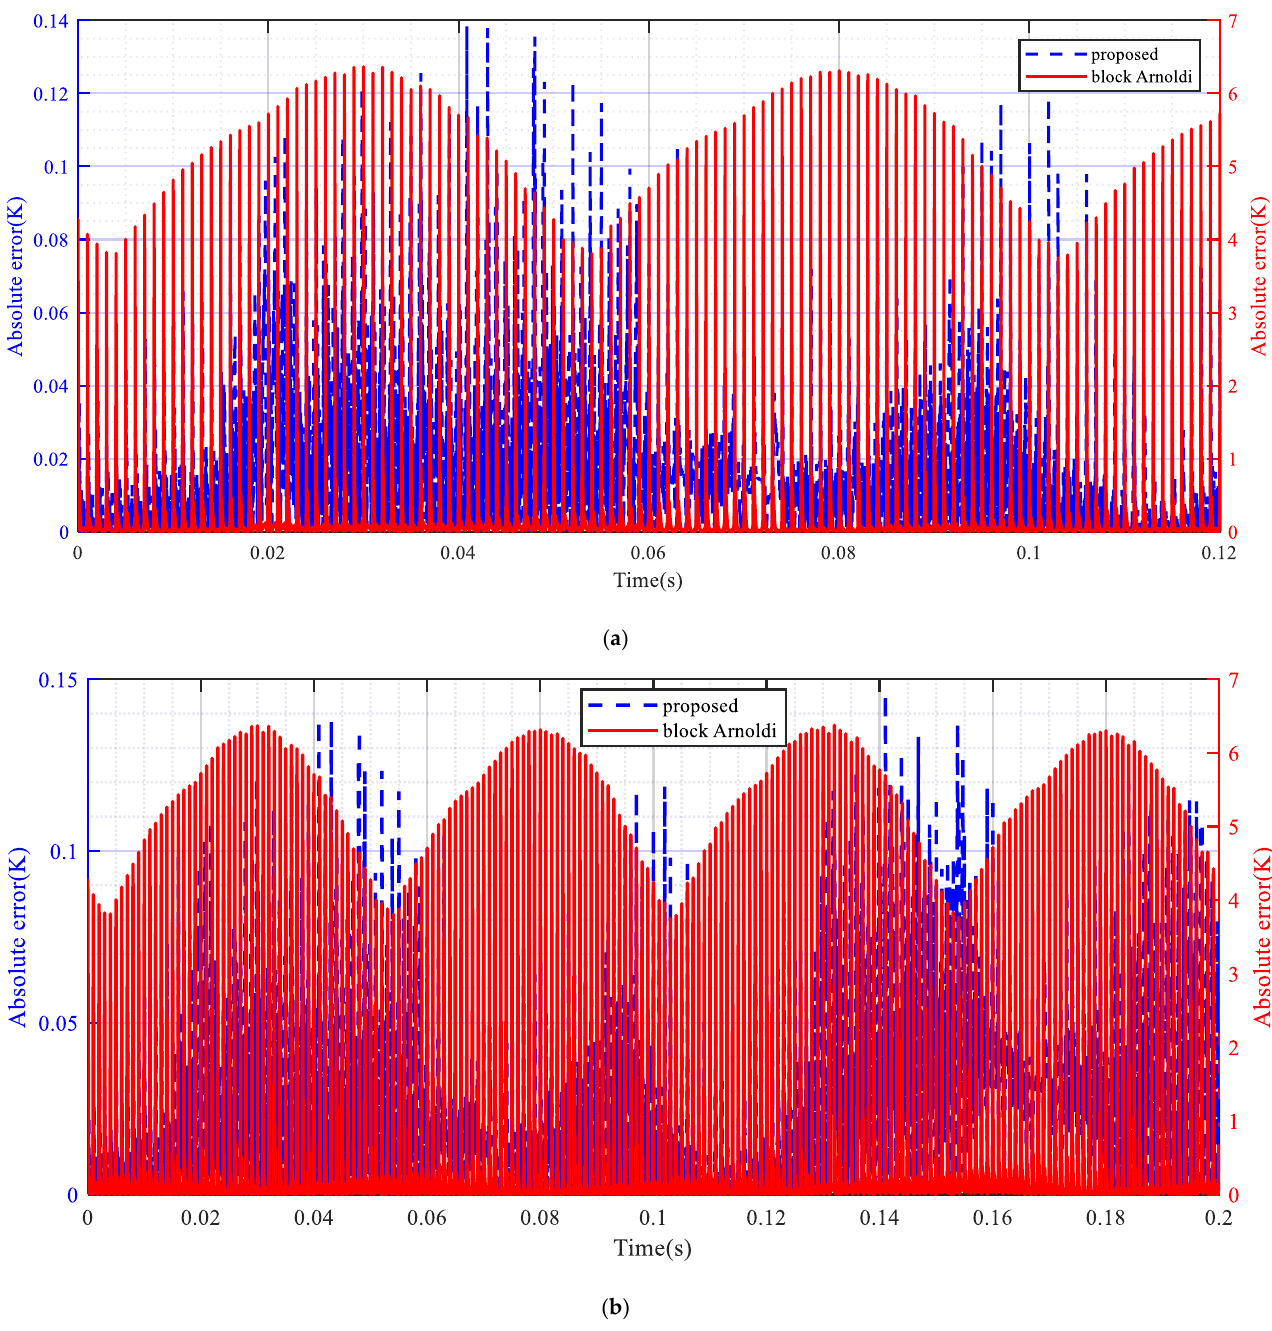
Figure 9. Absolute errors of the computed temperatures on observing point 3, using the conventional block Arnoldi algorithm and the proposed scheme, compared to those of the original NTM model under the tested broad-frequency-excitation signal. ( a ) Zoom in (0–0.12 s). ( b ) Whole excitation duration (0–0.2 s). Table 1. Comparisons of the transient response on different observing points by using the proposed and NTM models. Analysis